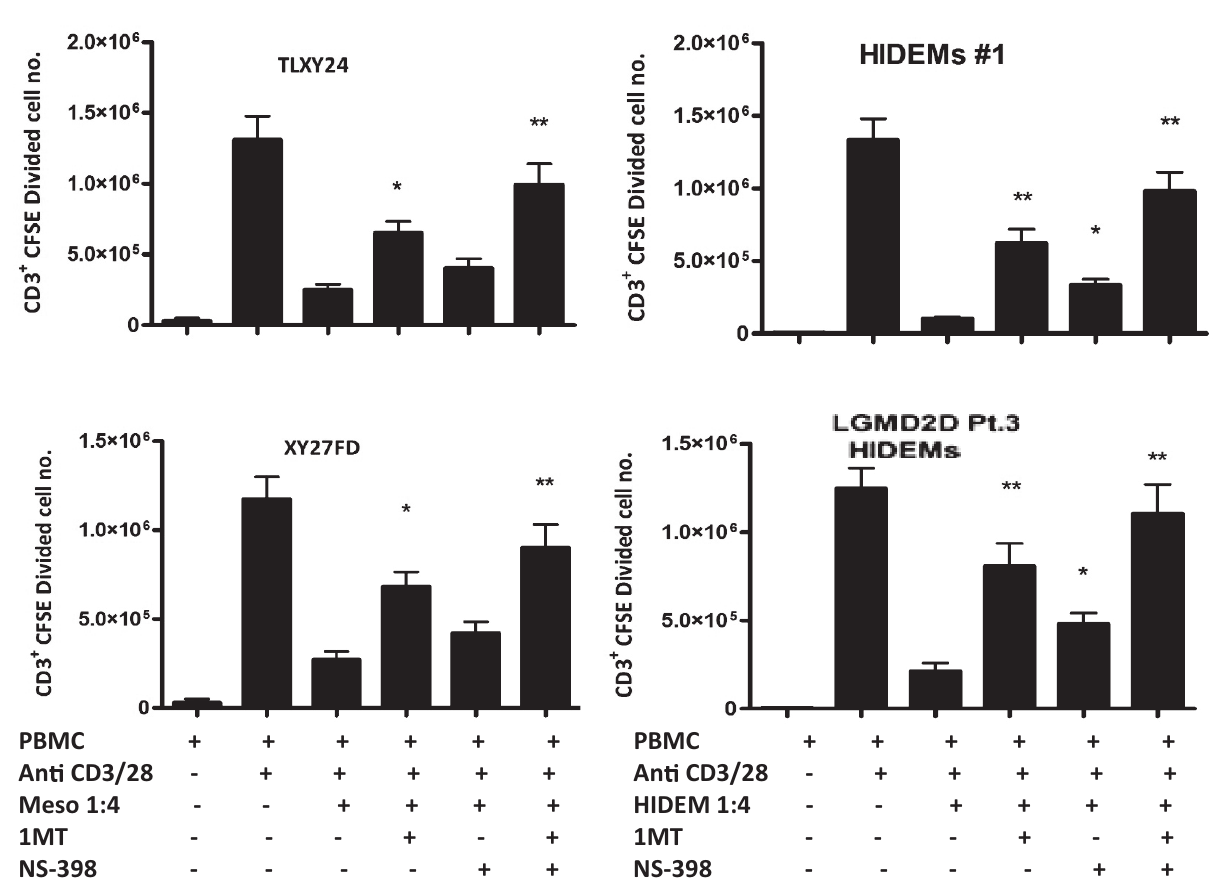
Figure 5. IDO and PGE-2 are involved in HIDEMs suppression of T cell proliferation. CFSE-labelled PBMCs were stimulated with anti CD3/CD28 beads as before in the presence of HIDEMs/mesoangioblasts and inhibitors of IDO and Cox-2, (1-Methyl-L-trypyophan (1MT) (0.5 mM) and NS-398 (1.0 uM) respectively, or both. On day 6 cells were harvested and stained with anti-CD3 and 7AAD. Cells were gated on live CD3 + populations and analysed for CFSE dilution and the numbers of cells undergoing CFSE dilution were enumerated using counting beads, *p<0.05, **p<0.01. Experiments were carried out in duplicates.